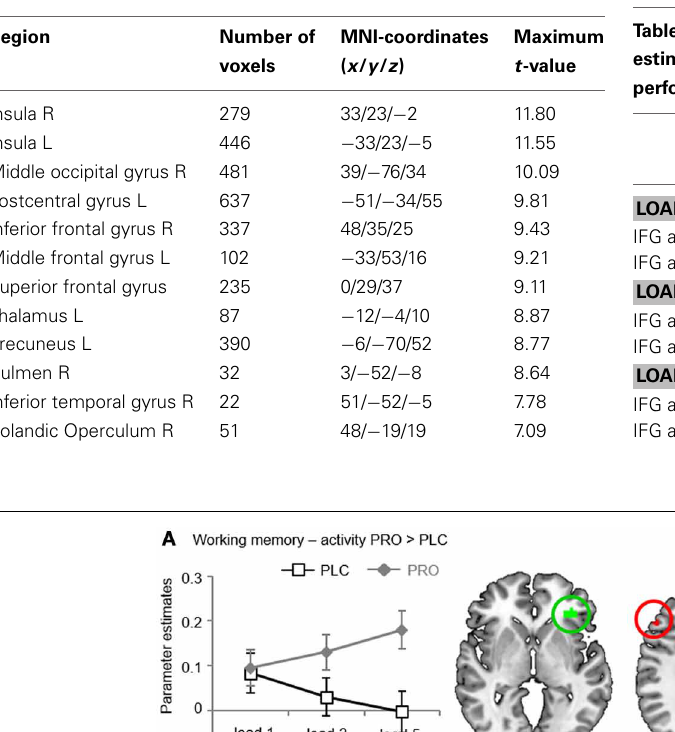
Table 3 | Significant main effect of working memory load (“load 3 + load 5 > load 1”) in the entire sample ( n = 36) thresholded at p > 0 . 05 (FWE-corrected).